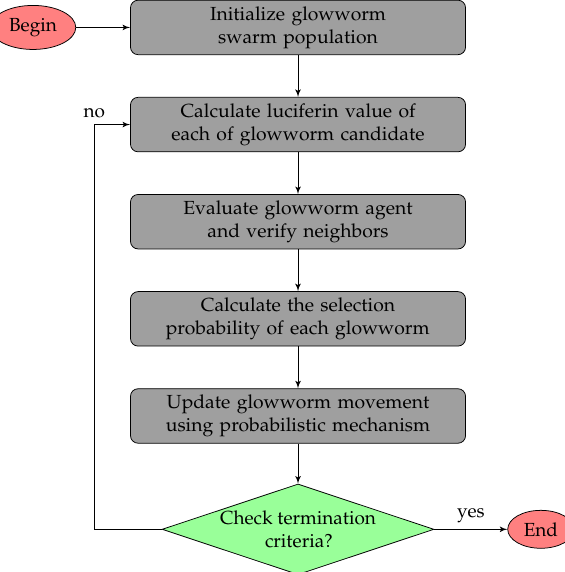
Figure 1. Flowchart of GSO procedure.